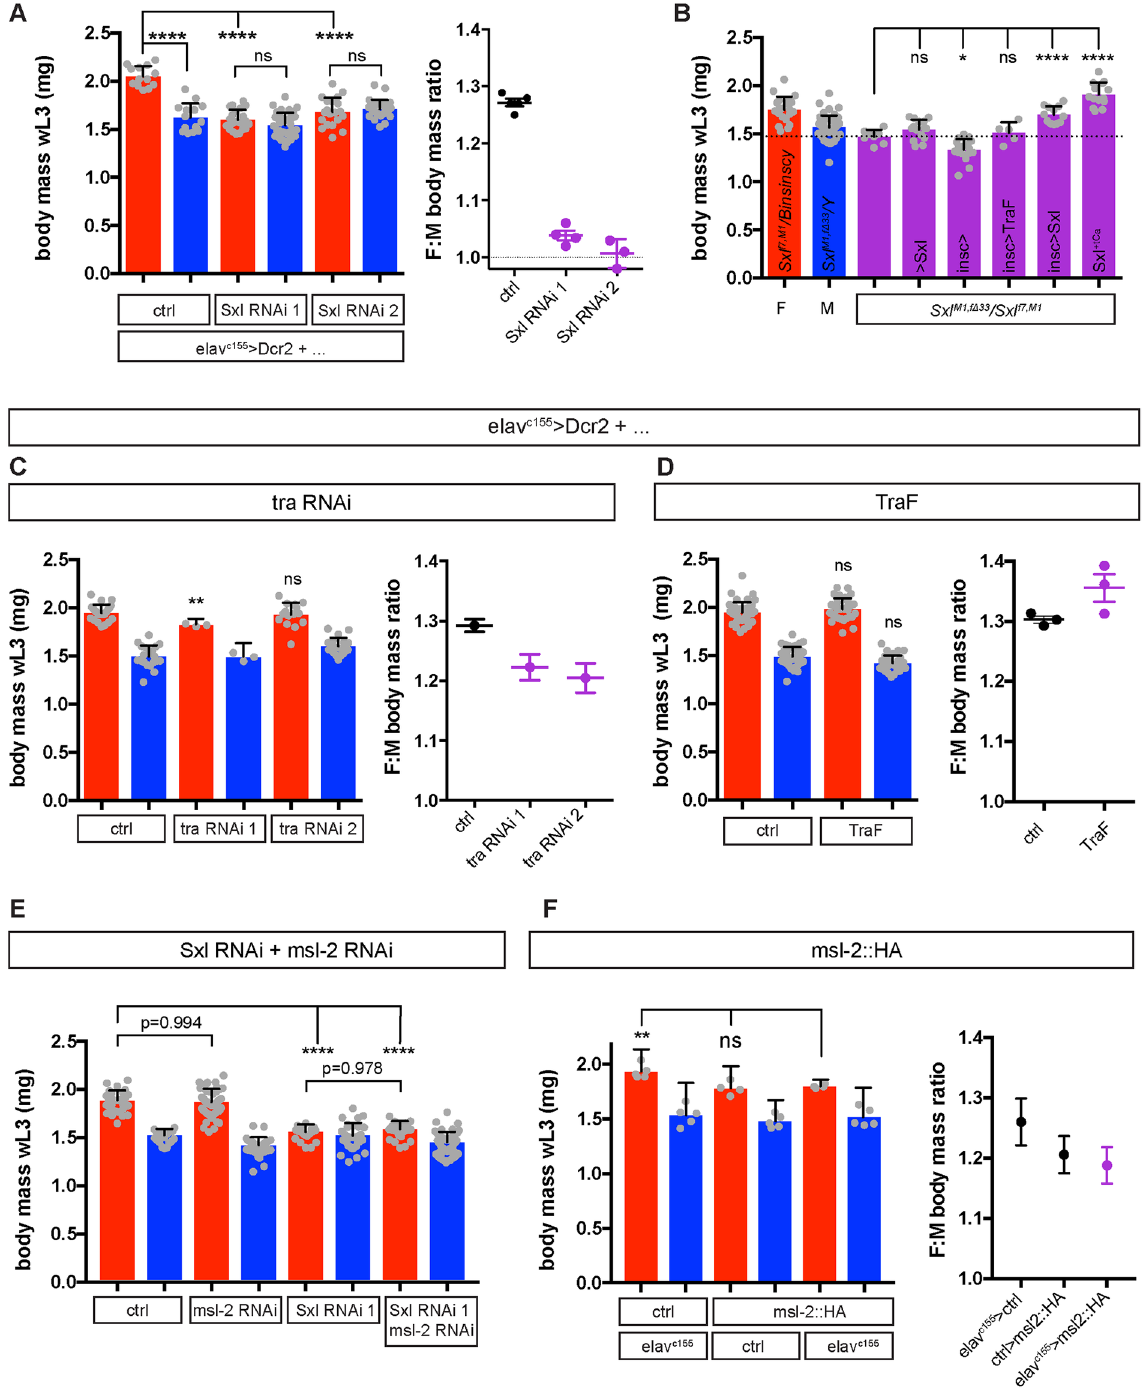
Fig 3. Sxl functions in the nervous systemto control larval sexual size dimorphism (SSD). (A) RNAi-mediated knockdown of Sex-lethal ( Sxl ) in all neurons( elav c155 -Gal4 ) specificallyreduces female body mass in wanderingL3 larvae (wL3). This abolishes sex differences in body mass, leadingto a female to male ratio (F:M ratio) near 1. Body mass data shows representative results of 3 independent experiments, F:M ratio data shows mean ratio, individual ratios, and SEM of 3–4 independentexperiments. (B) Rescue of wL3 body mass of Sxl M1, Δ 33 /Sxl f7, M1 mutant females by neuronalexpressionof upstream activationsequence(UAS)-Sxl ( Insc > Sxl ) but not of the female splice variant of transformer , UAS-TraF ( Insc > TraF ). (C–D) Pan-neuronal knockdown of transformer (tra) (C) or overexpression of the female-specific tra splice variant (TraF) (D) has minor or no effects on body mass and SSD. In (C),